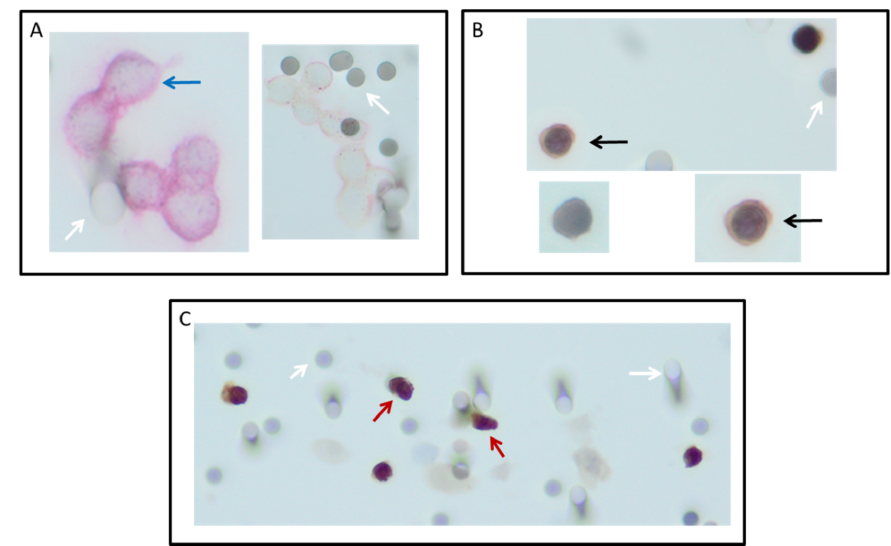
Figure 3. Circulating tumor cells (CTCs) detected on ISET filters after filtration of diagnostic leukapheresis product of non-small-cell lung cancer (NSCLC) patients. CTCs were detected with immunocytochemistry in three different manners: Cells positive for the epithelial cell adhesion molecule (stained red) with CD45 (stained brown) as a negative marker ( A ); TTF1 or p40 (stained brown) as a positive marker, with CD45 as a negative marker (stained red); ( B ) and a combination of TTF1 with EpCAM ( C ). Images were taken with a focus of 200×. White arrow: 8 µm pores of the filter. Red arrow: two cells suspected to be EpCAM and TTF1 positive; black arrow: TTF1-positive, EpCAM-negative cell, blue arrow: EpCAM-positive cell.